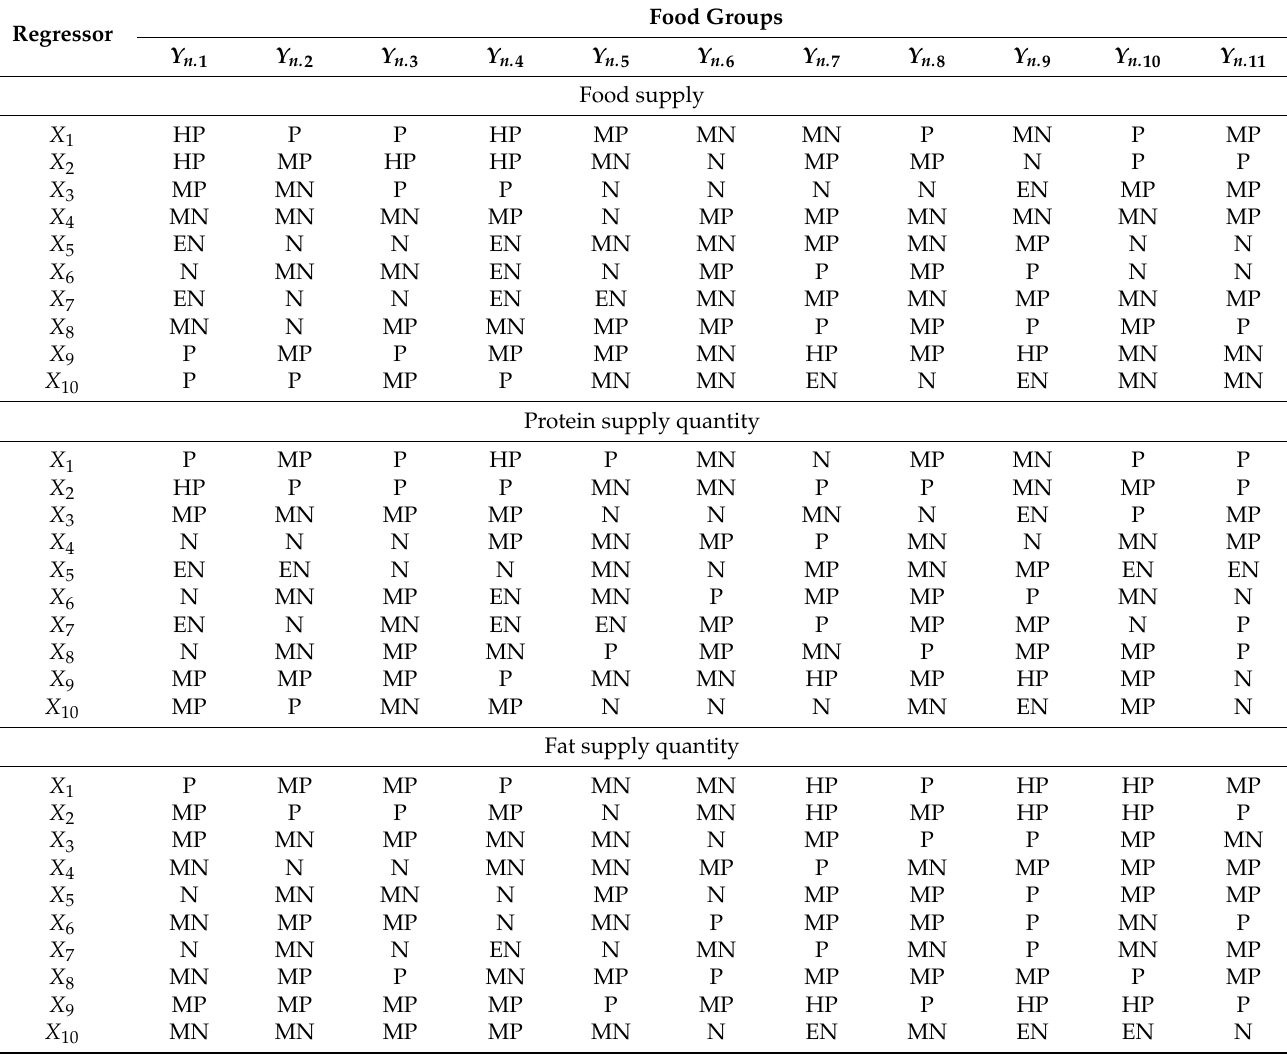
Table 7. The effects of X n on Y n in low-income